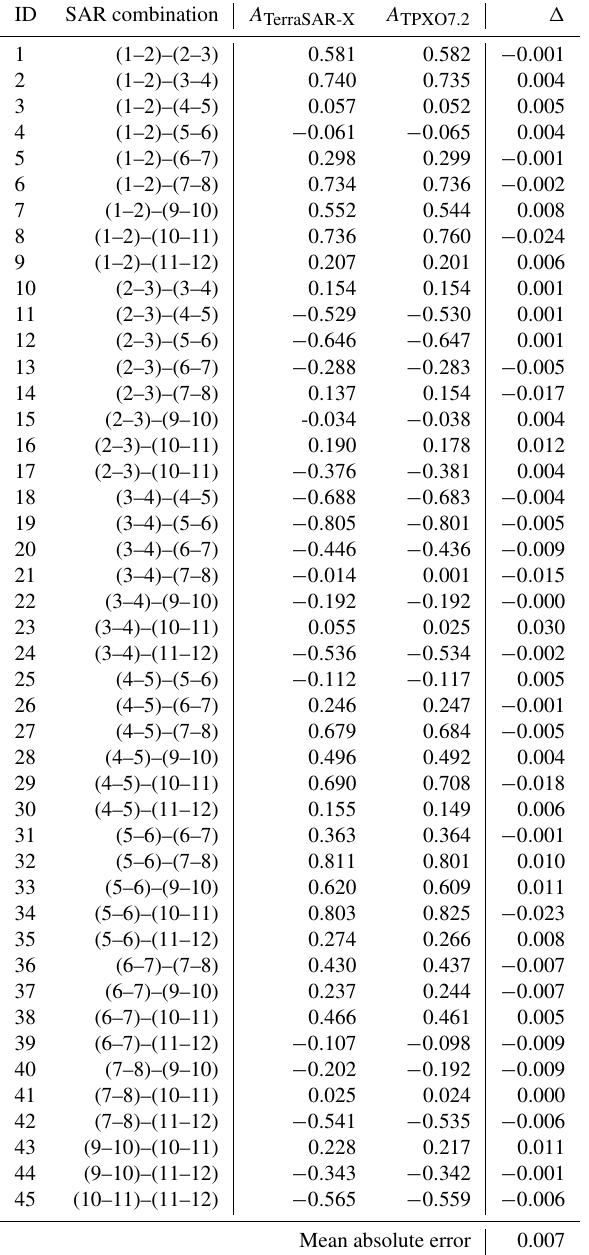
Table 2. DInSAR images of the Darwin Glacier. The SAR combi- nation from 12 available SAR images, and the tidal amplitude ( A in m) as measured at the Shirase location as well as predicted with the TPXO7.2 tide model.